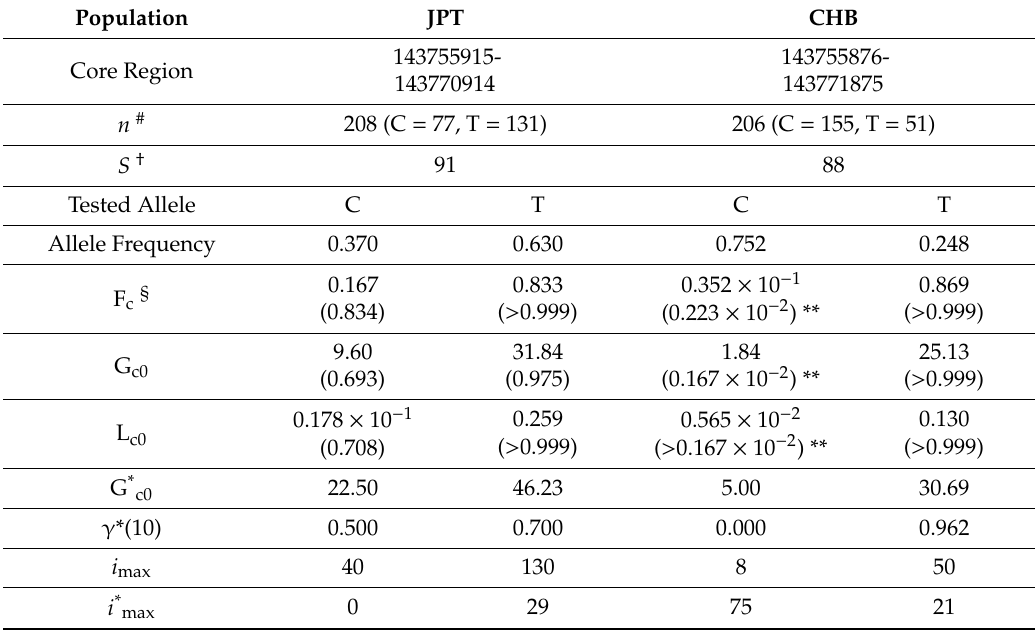
Table 1. Summary statistics of two-dimensional site frequency spectrum (2D